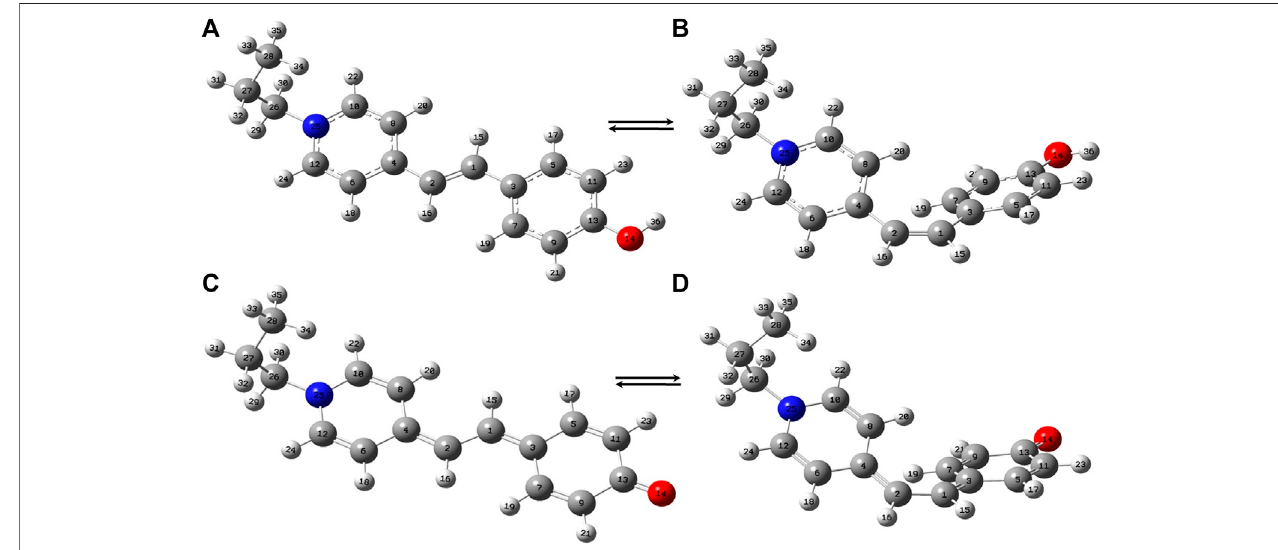
FIGURE1| Optimizedmolecularstructuresof (A) trans -MCH + , (B) cis -MCH + , (C) trans -MCand (D) cis -MC.ThecolorcodesusedtoidentifytheatomsareO(red), N (blue), C (grey) and H (white).